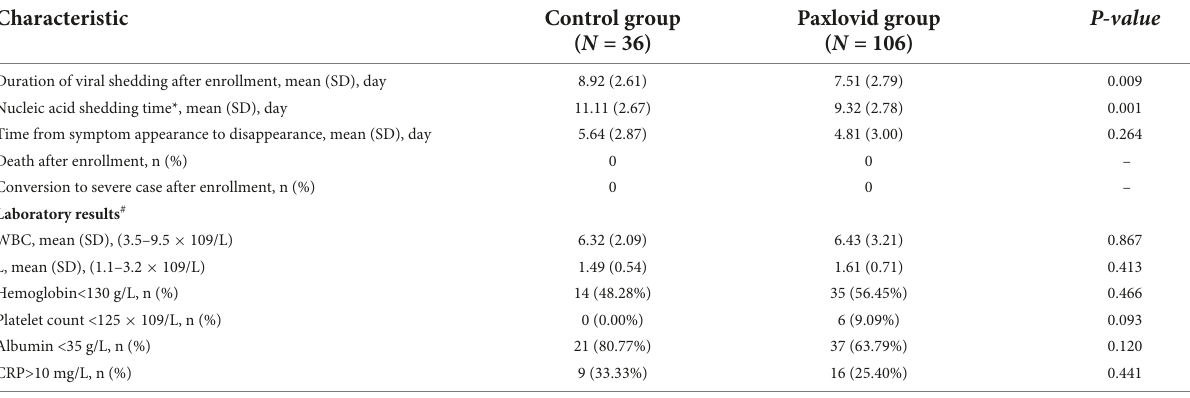
TABLE 3 Outcomes in patients with infected with SARS-CoV-2 omicron. Characteristic